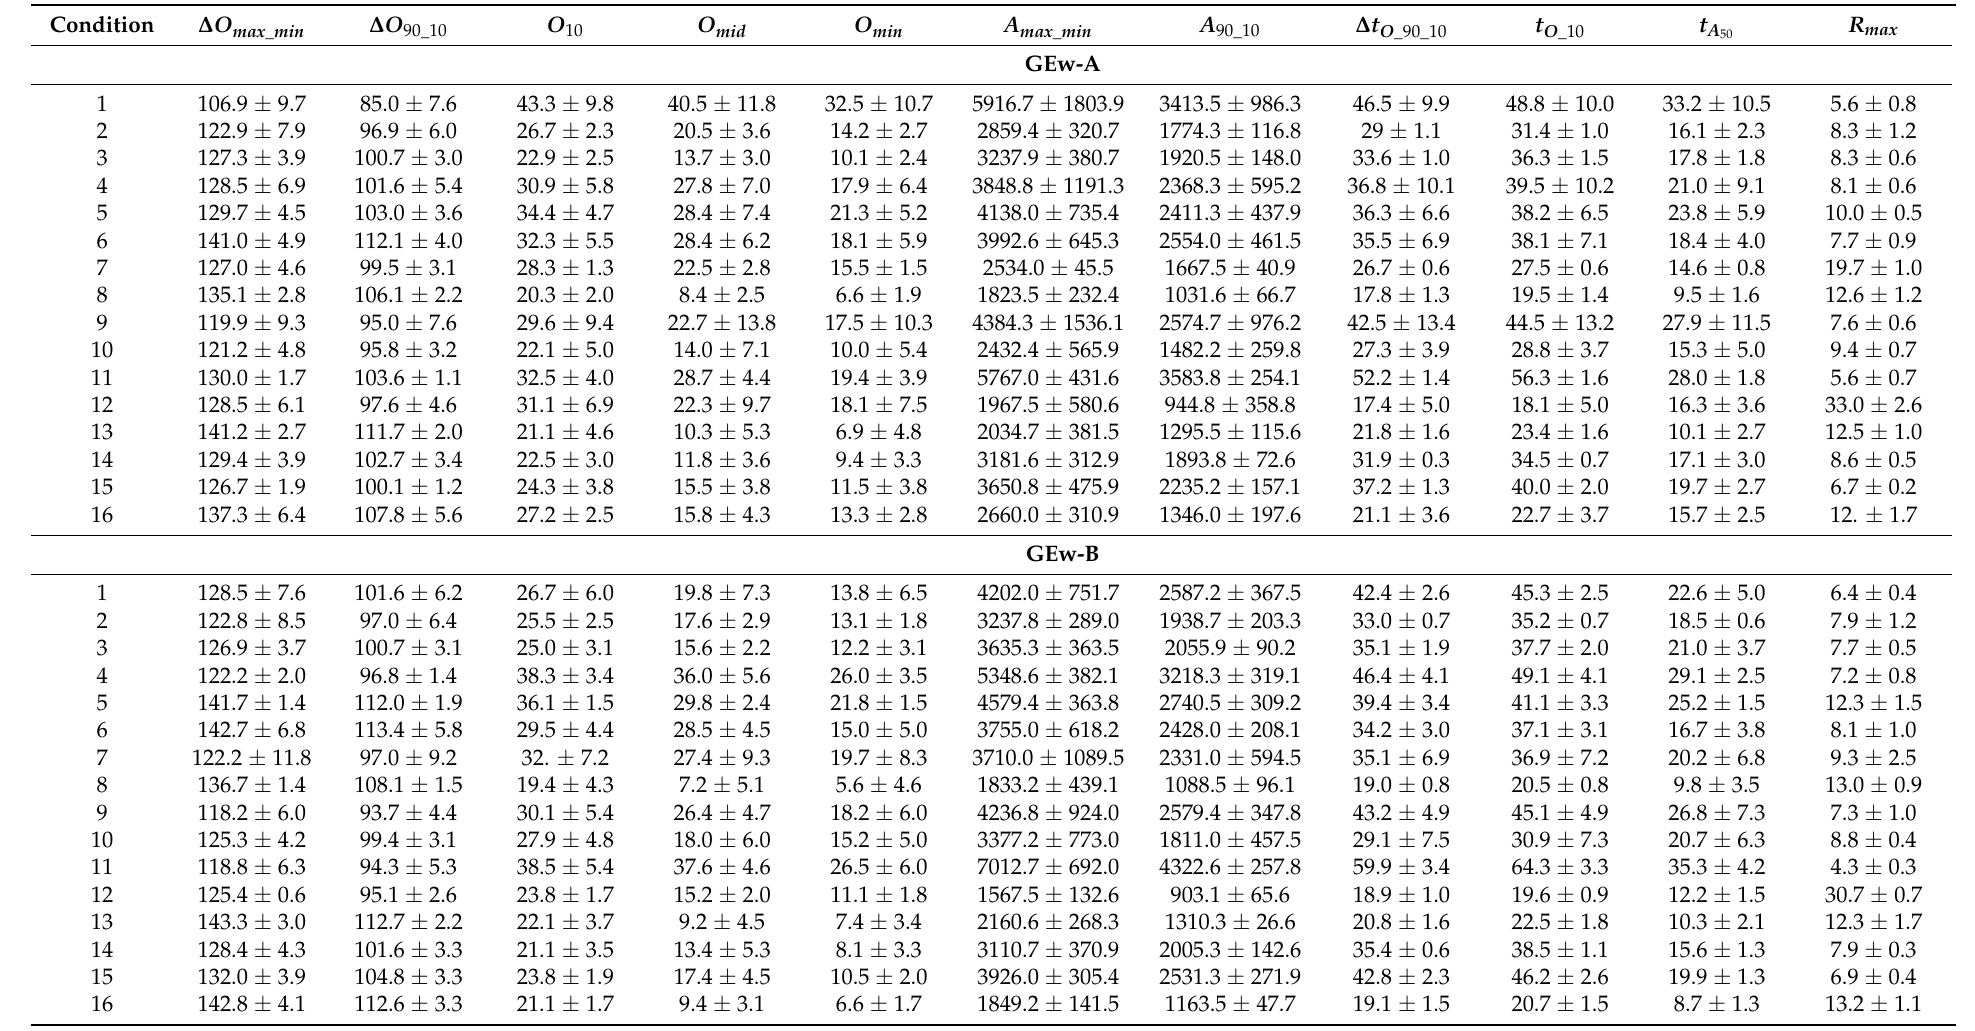
Table 2. Mean and standard deviation of each consumption kinetic parameter in the different experimental conditions for each